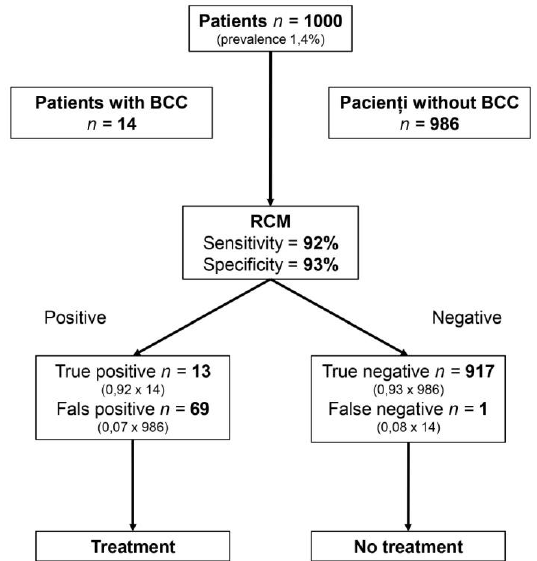
Figure 8. The consequences of using reflectance confocal microscopy for BCC diagnosis in a cohort of 1000 subjects. The use of RCM would lead to 82 patients being treated, of which 69 would not need to be treated; 918 patients would not be treated, of which only one would have necessitated treatment. BCC, basal cell carcinoma; RCM, reflectance confocal